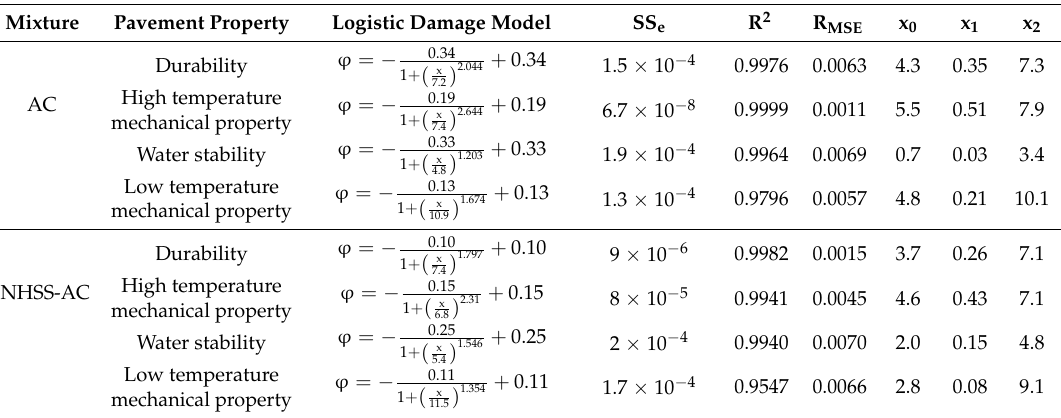
Table 5. Fitting result of the logistic damage model. Table 6. Fitting result of the logistic damage